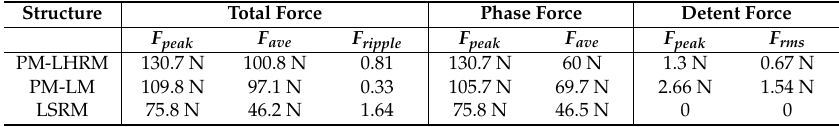
Figure 11. Total force simulation comparison results for the PM-LHRM and PM-LM, s = 4 mm, and the LSRM at 10 A/mm 2 . Table 1. Main comparison simulation results from PM-LHRM, PM-LM, and